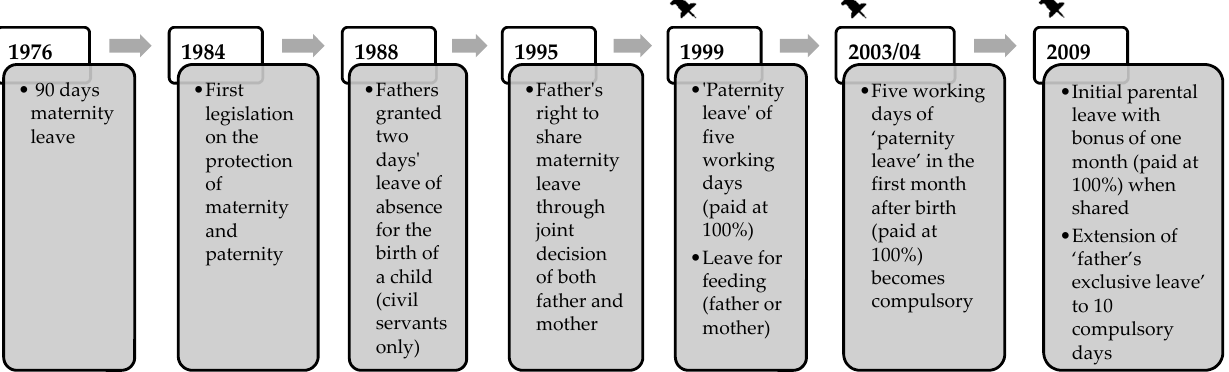
Figure 3. Developments in the legislation governing parenthood protection, 1976-2009